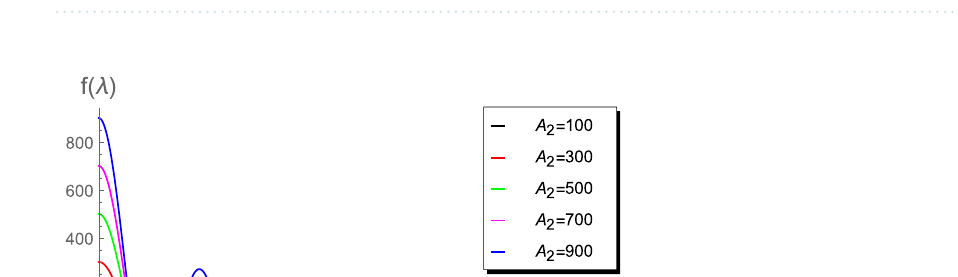
Figure 4. Plot of f ( (cid:31) ) vs (cid:31) for A 2 = { 50, 60, 70, 80, 90 } .